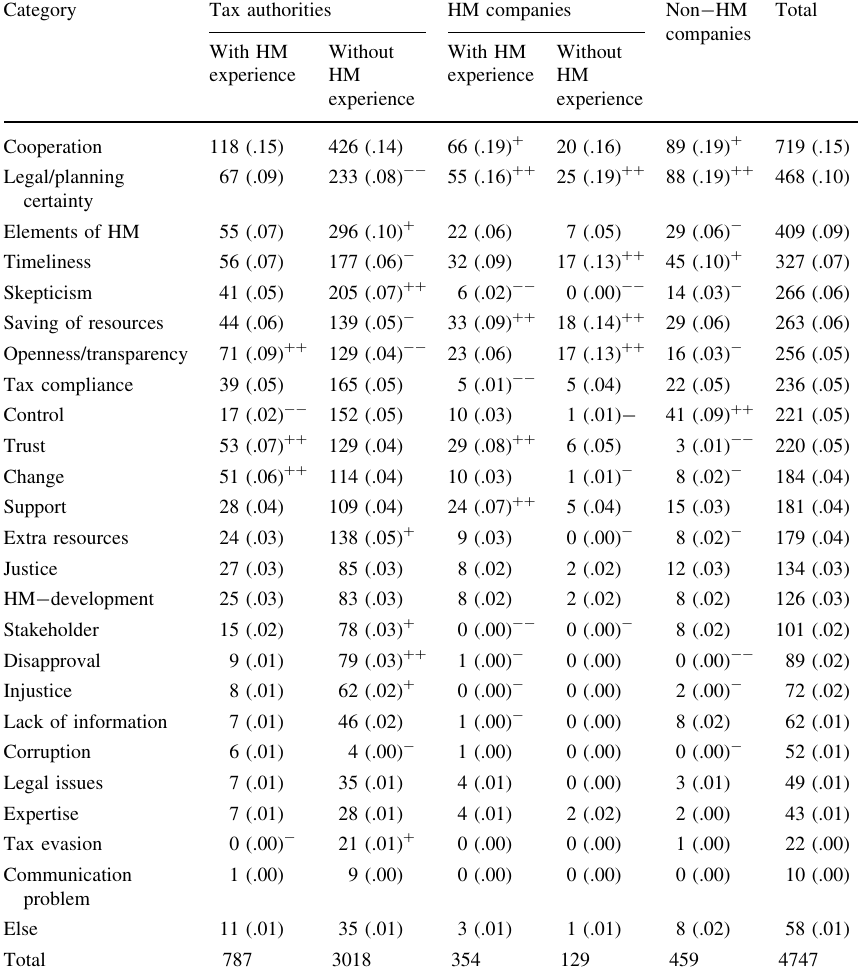
Table 3 Frequencies of free associations to the stimulus ‘‘Horizontal Monitoring’’ by categories and stakeholder groups (absolute counts and relative frequencies within groups in parentheses)